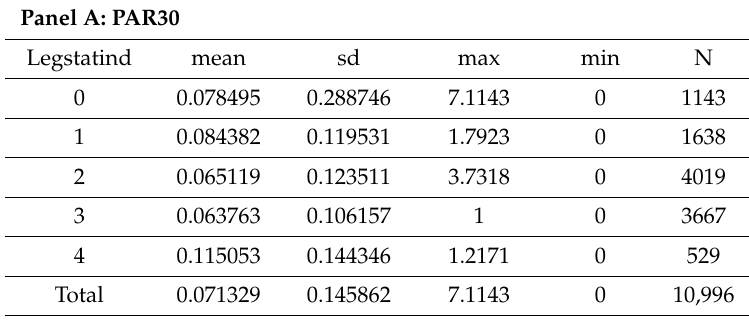
Table 3. Summary statistics for MFIs with different legal